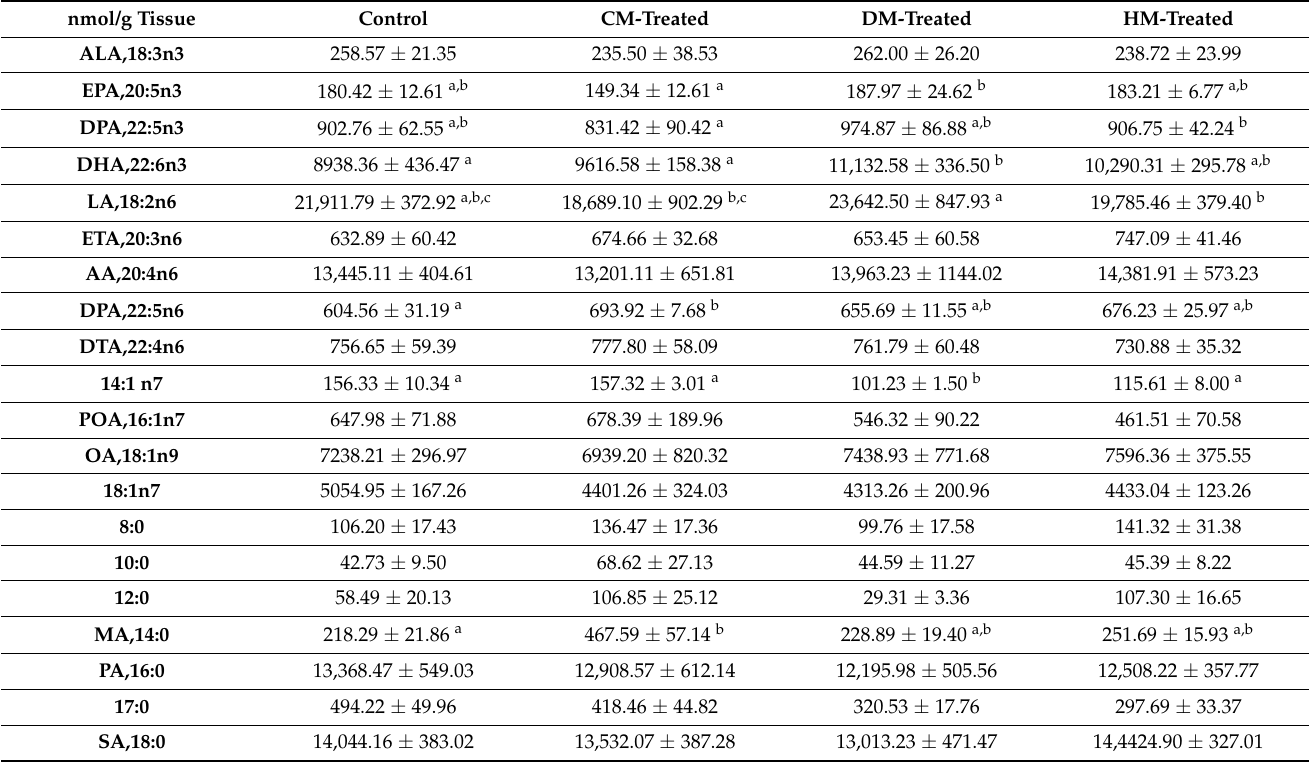
Table 2. Changes of fatty acid profile in heart of rats fed with CM, DM or HM diet supplementation. nmol/g Tissue Control